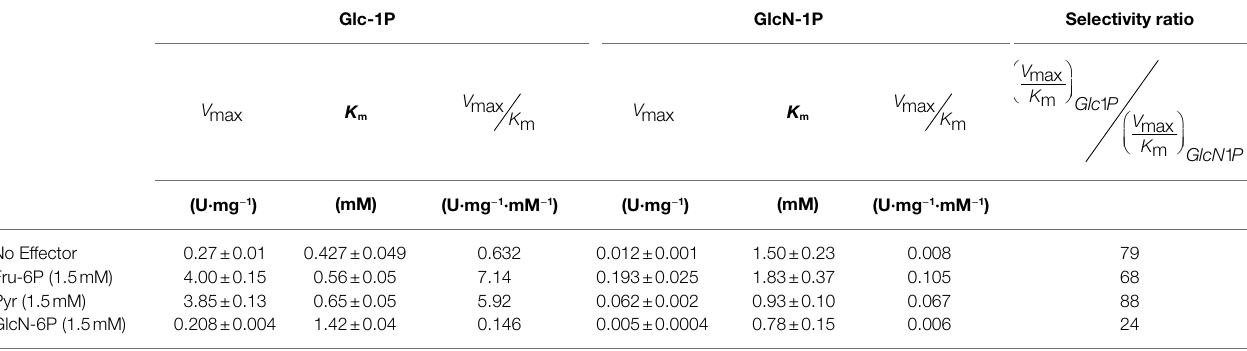
TABLE 1 | Kinetic parameters for E187A ADP-Glc PPase from A. tumefaciens with Glc-1P and GlcN-1P as substrates in the absence and presence of activators. Glc-1P GlcN-1P Selectivity